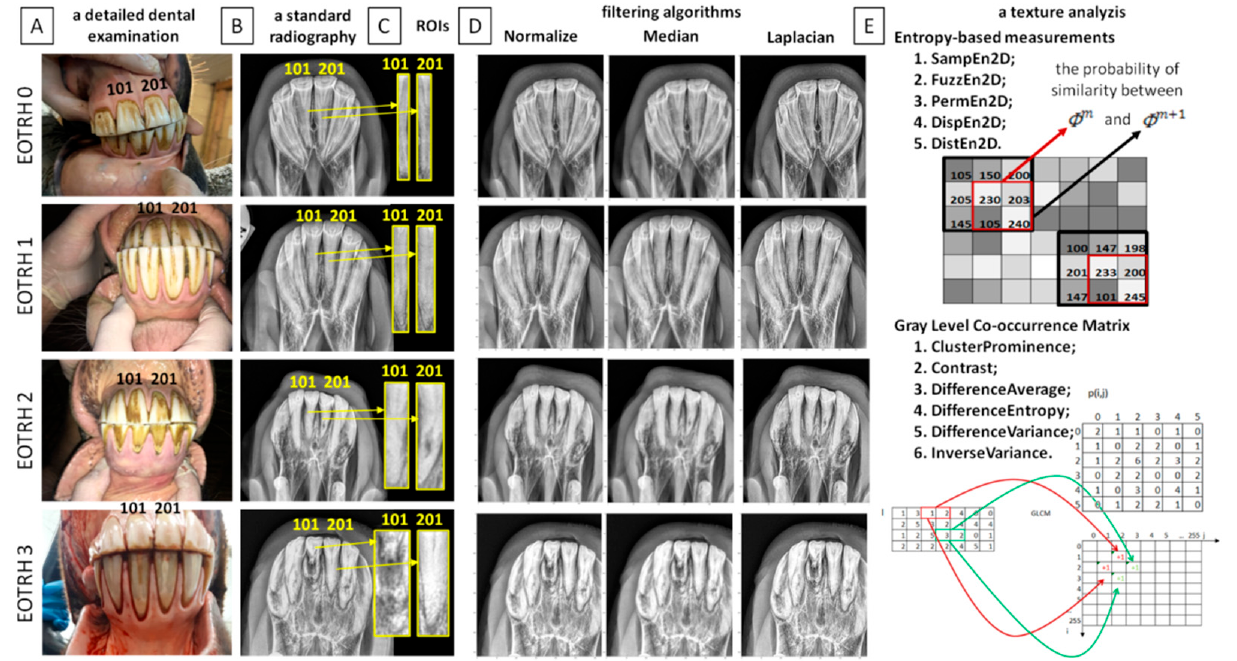
Figure 1. Scheme of radiographic–based detection of the signs of the Equine Odontoclastic Tooth Resorption and Hypercementosis (EOTRH) syndrome. A detailed dental examination ( A ); a standard radiography ( B ); segmentation of input radiographs with regions of interest (ROIs) of the first upper right incisor tooth (101) and the first upper left incisor tooth (201) marked with yellow lines ( C ); filtering of input radiographs by three filters—Normalize, Median, and Laplacian Sharpening ( D ); a texture analysis of output radiographs after filtering using entropy–based measures (five measures: SampEn2D—two–dimensional sample entropy, FuzzEn2D—two–dimensional fuzzy entropy, PermEn2D—two–dimensional permutation entropy, DispEn2D—two–dimensional dispersion entropy, DistEn2D—two–dimensional distribution entropy) and Gray–Level Co–occurrence Matrix (six selected features: Cluster Prominence, Contrast, Difference Average, Difference Entropy, Difference Variance, Inverse Variance) ( E ).